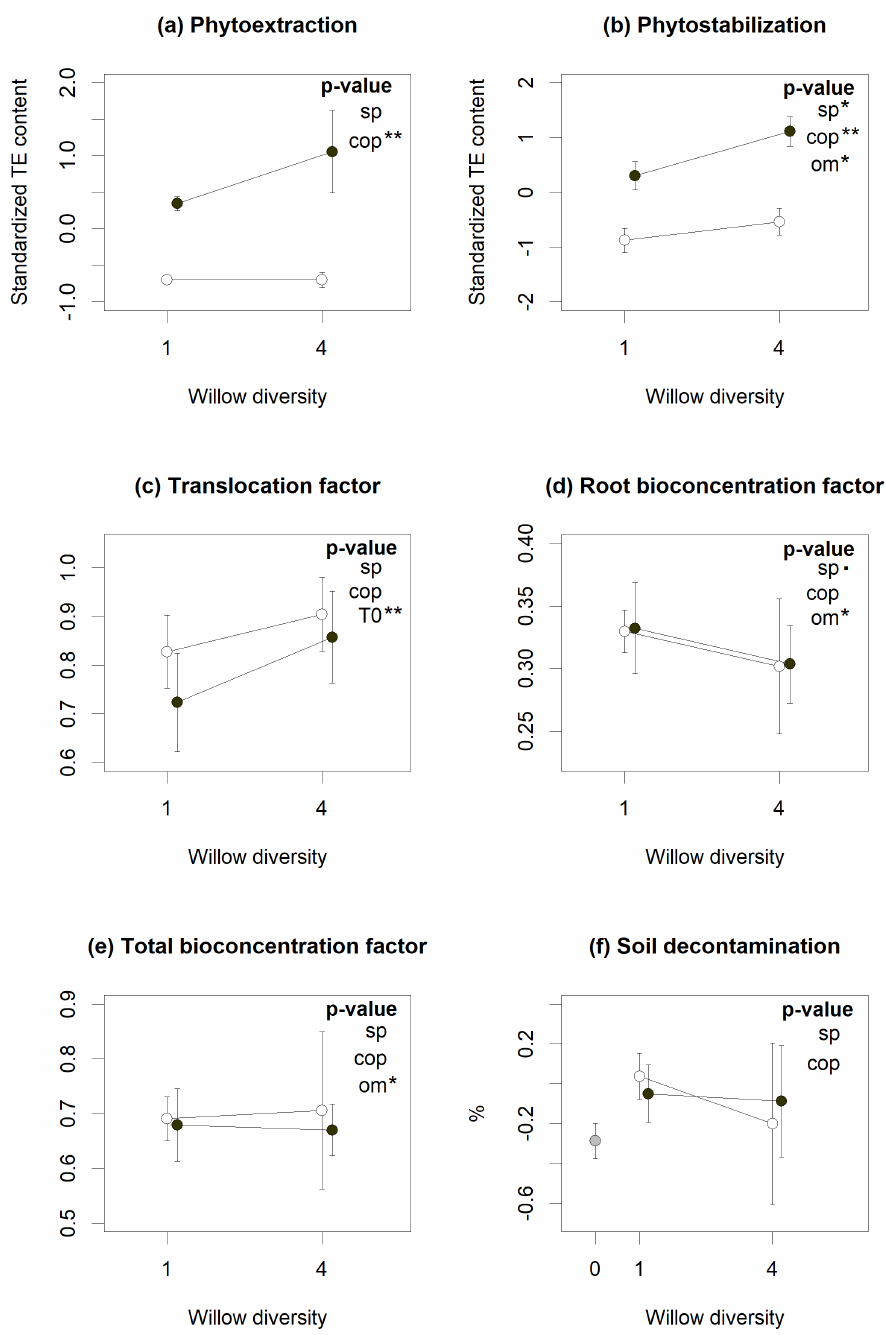
Figure 1. Influence of willow diversity (number of cultivars) (sp), coppicing (cop) and environmental factors (Organic matter (OM), clay (clay) and sand (sand) content and initial contamination content (t0)) on phytoremediation services ( a − f ). Dots represent the services means across the eight TE and the standard error bars of each cross-treatment. The unplanted control (grey symbol), coppiced (open symbols) and non-coppiced (closed symbols) treatments are aligned above the number of species unplanted (0), monoculture (1) or polyculture (4) plots). According to linear mixed models, treatments or factors with significant p -values are indicated by (.) for p < 0.10, (*) for p < 0.05 and (**) for p <